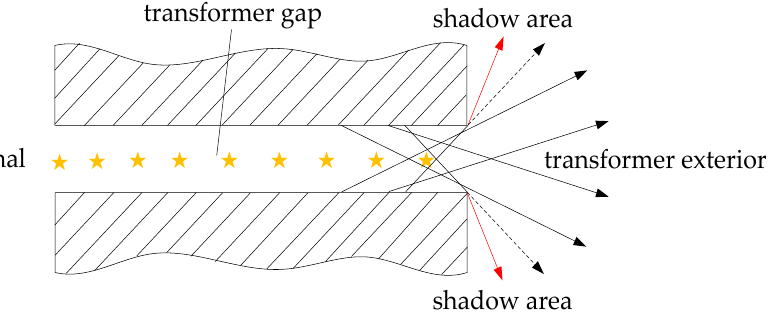
Figure 5. Schematic diagram of electromagnetic wave in transformer gap exit.